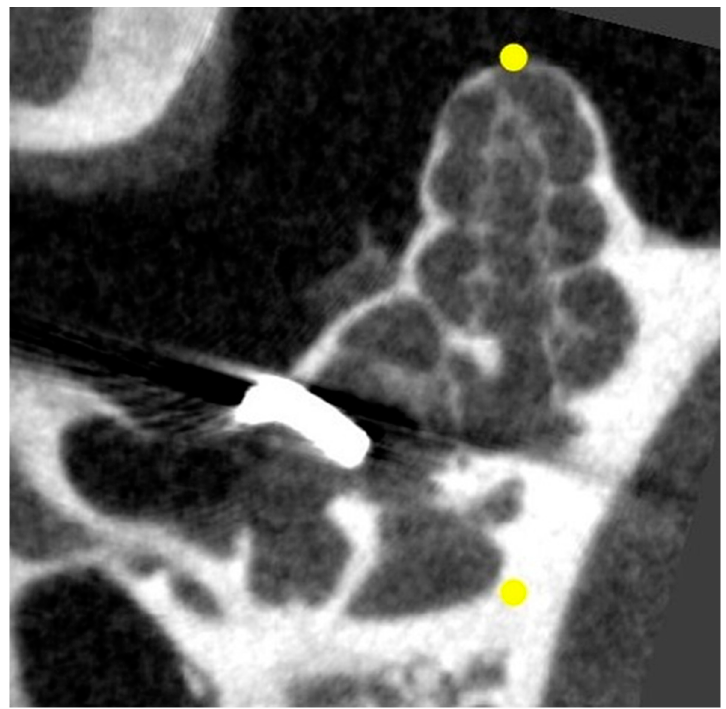
Figure 13. μ CT scan of an implanted guinea pig cochlea. Analysis of the hook position was carried out by visual inspection of the DICOM data using COMET [42]. The yellow points indicate the rotation axis in the 3D reconstruction.